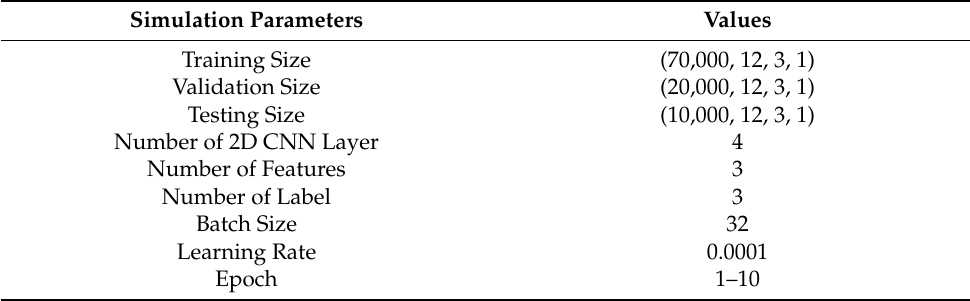
Table 3. Simulation parameters for training DLDC model.